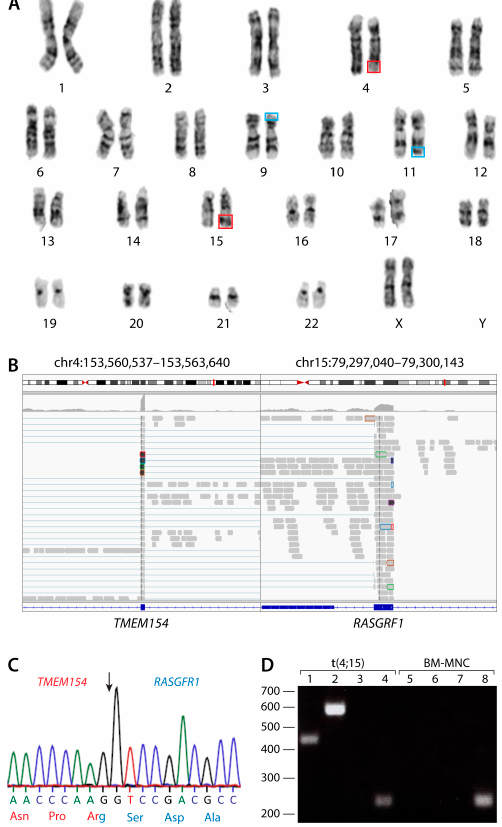
Figure 1. Analysis of the t(4;15)(q31;q22) reciprocal chromosomal translocation. ( A ) Conventional karyotyping showing 46,XX,t(4;15)(q31;q22), outlined in red and t(9;11)(p22;q23), outlined in blue. Chromosome analysis was performed on 20 G-banded metaphase cells from multiple unstimulated cultures. Both translocations were present in all cells examined. ( B ) Breakpoint analysis of the novel fusion transcript produced by the t(4;15) chromosomal translocation. TMEM154 and RASGRF1 form a chimeric mRNA transcript with the breakpoint indicated by the black arrow. ( C ) Sanger sequencing chromatogram showing the transcribed sequence surrounding the breakpoint. ( D ) PCR analysis of TMEM154 - RASGRF1 , RASGRF1-TMEM154, and TMEM154 transcripts. PCR was performed on t(4;15) acute myeloid leukemia (AML) cells (lanes 1–4) and bone marrow mononuclear cells (BM-MNCs) from a healthy donor (lanes 5–8). Bands correspond to a 445 bp product amplified from TMEM154 - RASGRF1 mRNA (lanes 1 and 5), a 589 bp product amplified from TMEM154 - RASGRF1 mRNA (lanes 2 and 6), and a 445 bp product amplified from TMEM154 mRNA (lanes 4 and 8). No product was amplified using primers corresponding to RASGRF1-TMEM154 mRNA (lanes 3 and 7).